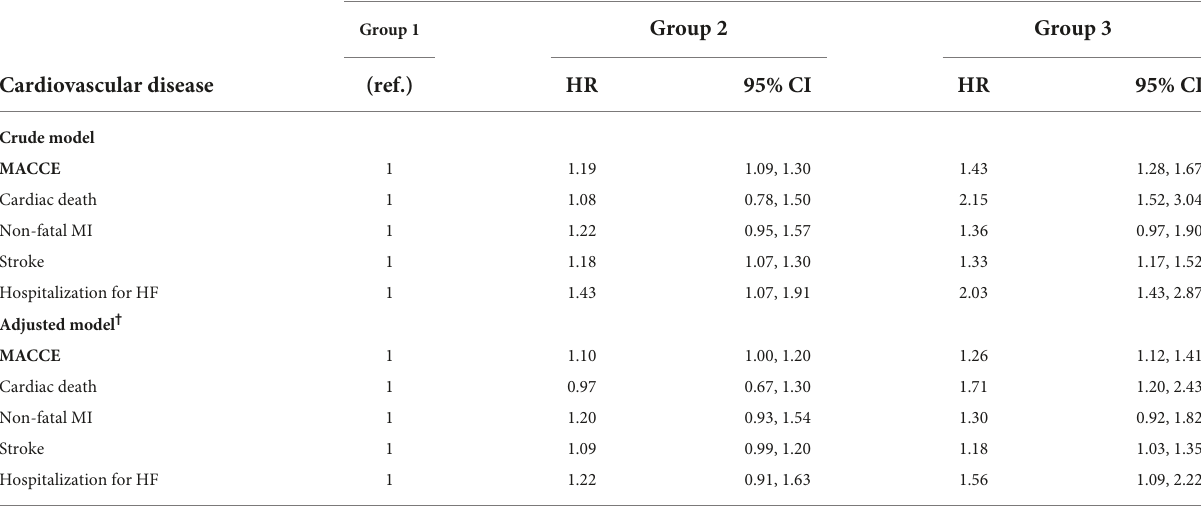
TABLE 5 The hazard ratios of major adverse cardiovascular and cerebral events per the annual height decrease rate in patients aged ≥ 60 years. Annual rate of height decrease ††††††